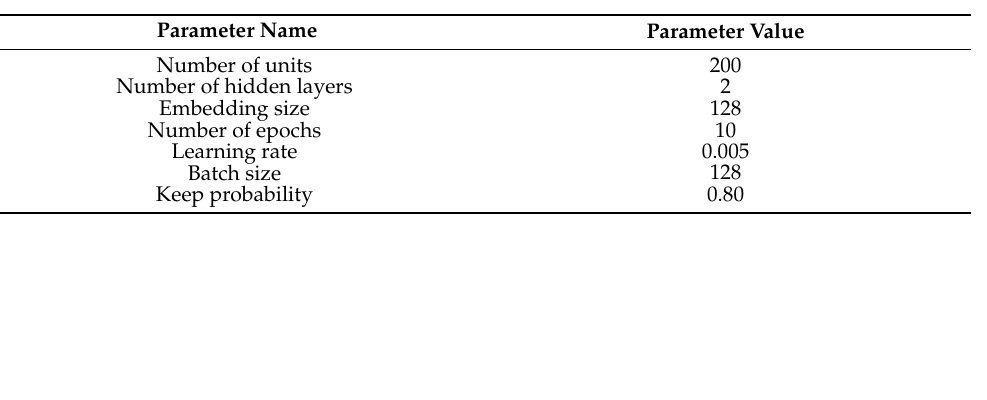
Table 5. Experiment parameters for beam width sensitivity